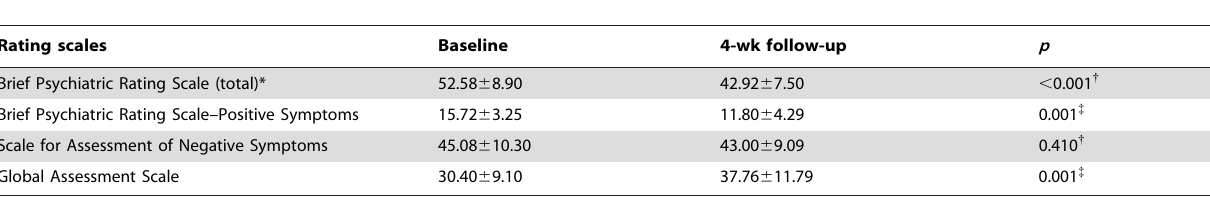
Table 2. Clinical assessments of first-episode neuroleptic-naı¨ve patients with schizophrenia (n =25).